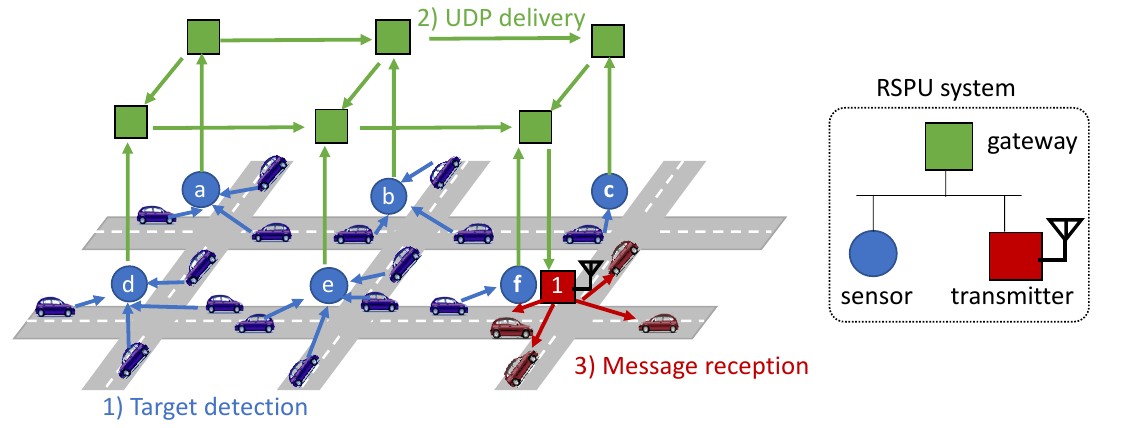
Figure 5. Overview of the networked